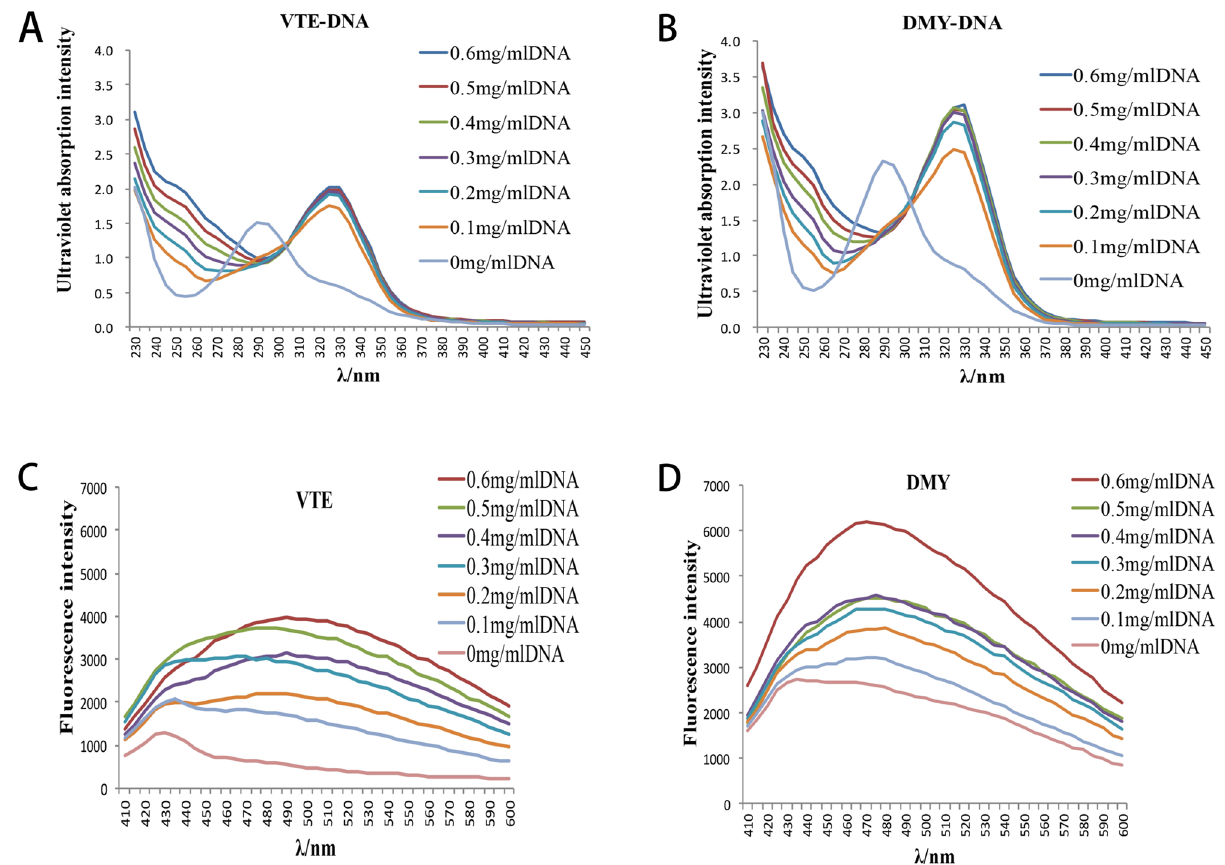
Figure 8. Effect of S. aureus Genomic DNA on Ultraviolet Spectra of VTE and DMY ( A , B ). Effect of S. aureus Genomic DNA on fluorescence Spectra of VTE and DMY ( C , D